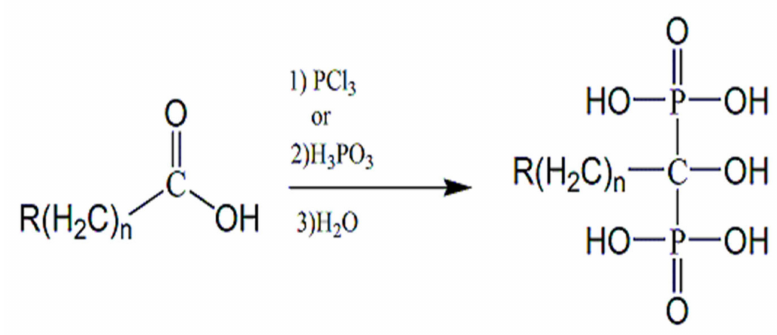
Figure 2. Classical route for the synthesis of hydroxy-bisphosphonates. The method requires the addition of (1) phosphorus trichloride or (2) phosphorous acid to that of carboxylic acid, followed by (3) hydrolysis to generate the